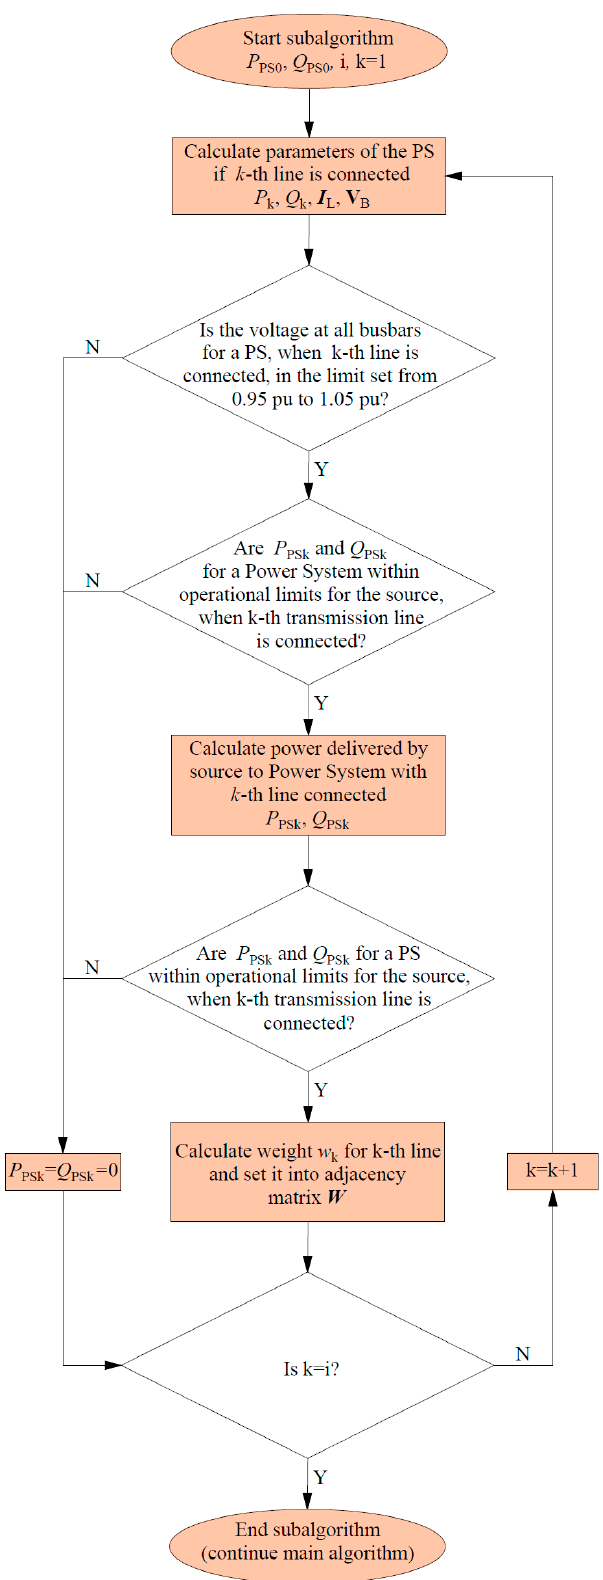
Figure 2. Weight calculation algorithm for strategies based on a single parameter only: real power, reactive power or apparent power.